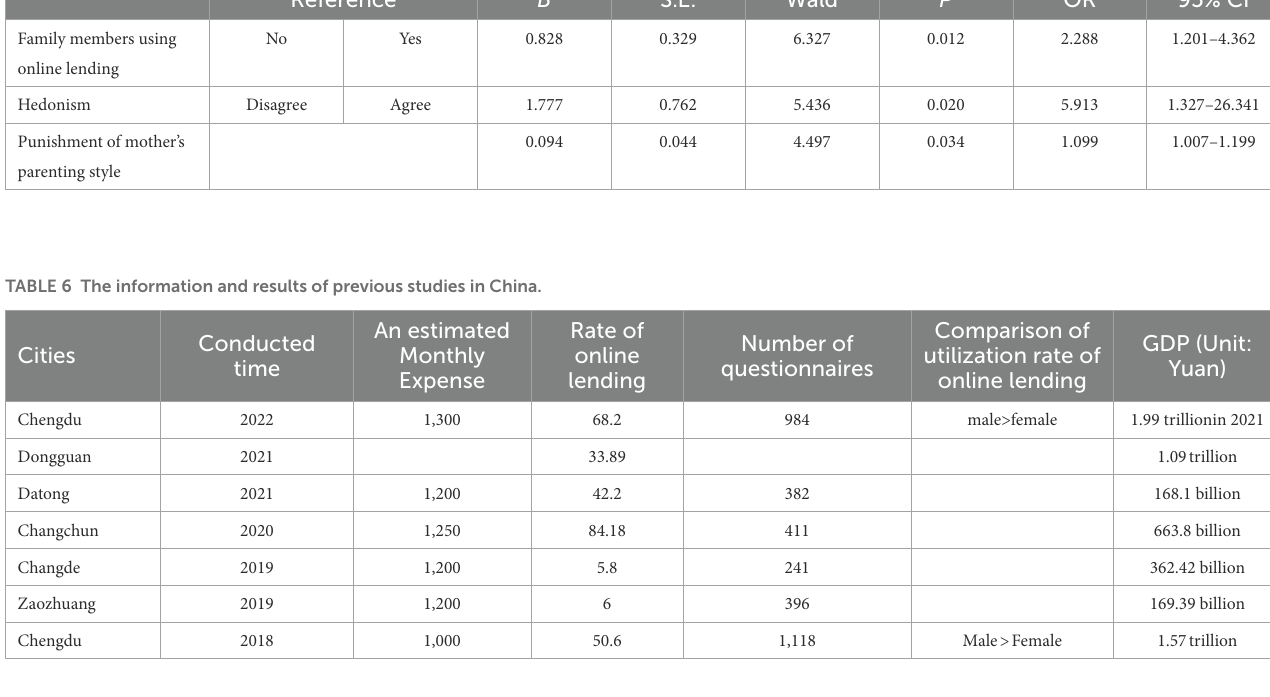
Number of questionnaires